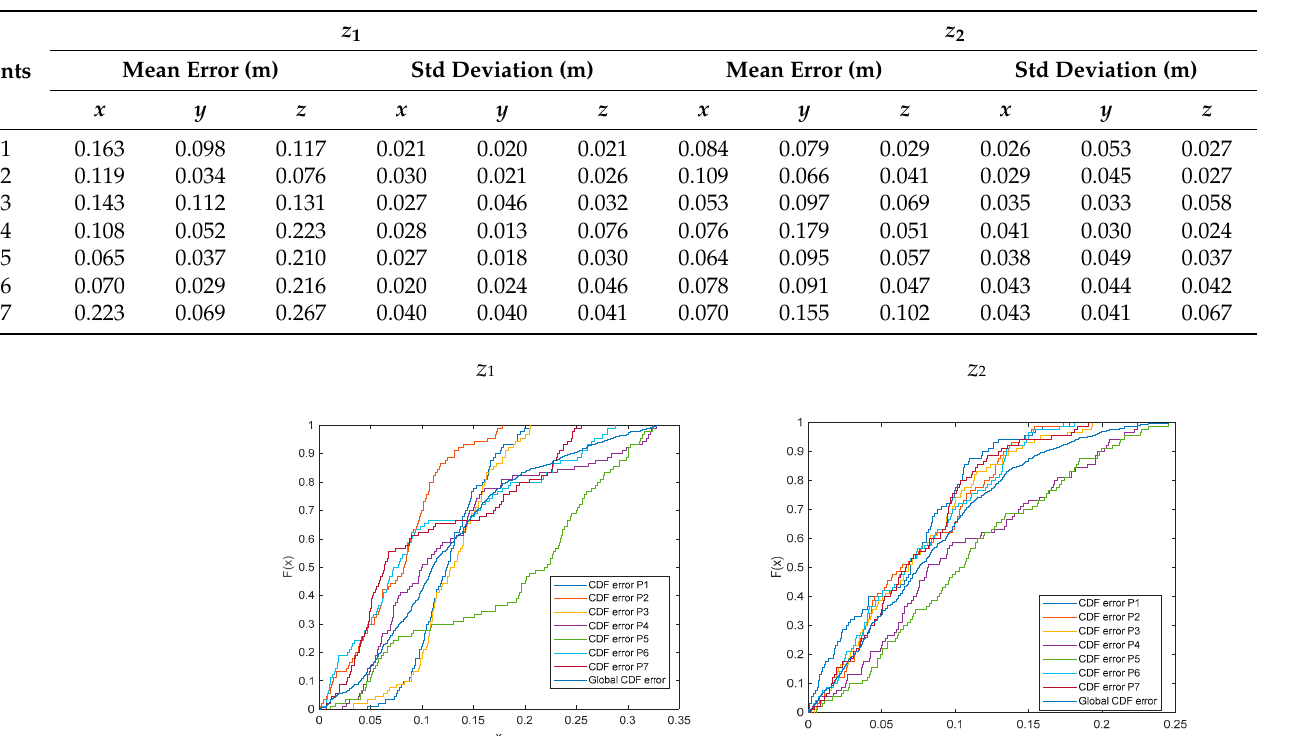
Table 7. Mean positioning errors and standard deviations for an EKF ( σ w = 0.2 m).